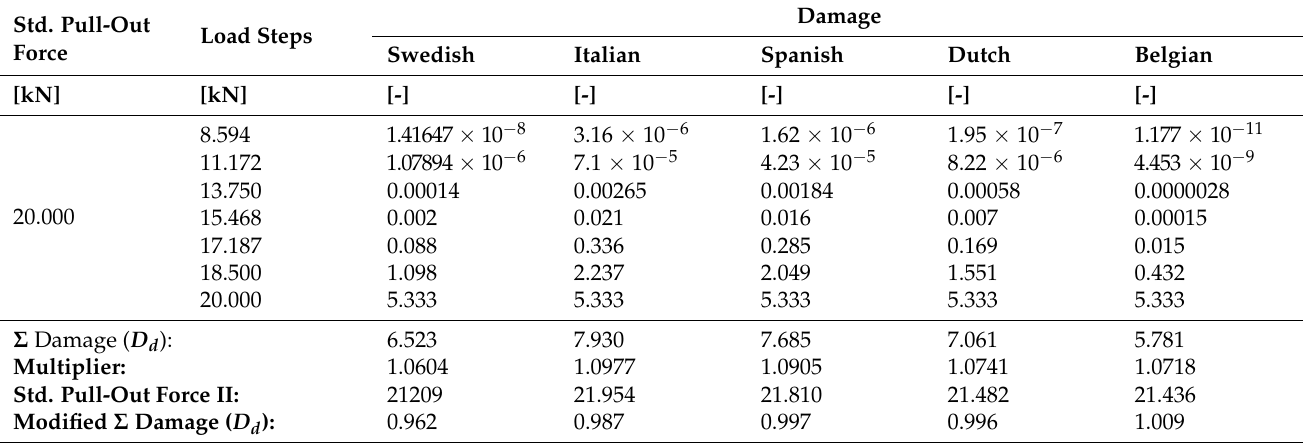
Table 10. Values of damage at different load levels (based on linear damage hypothesis) according to different national